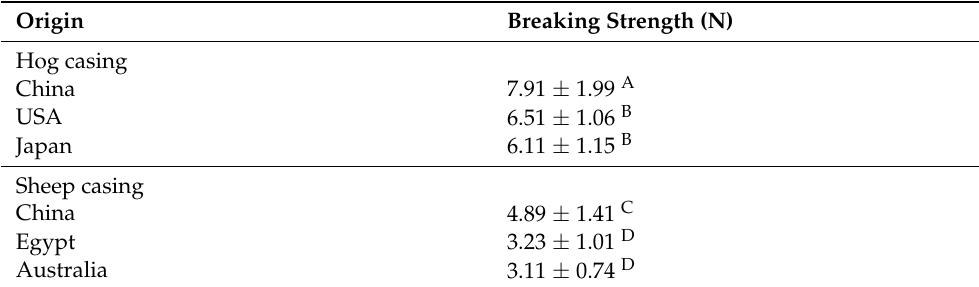
Table 1. Mechanical characteristics of natural hog and sheep